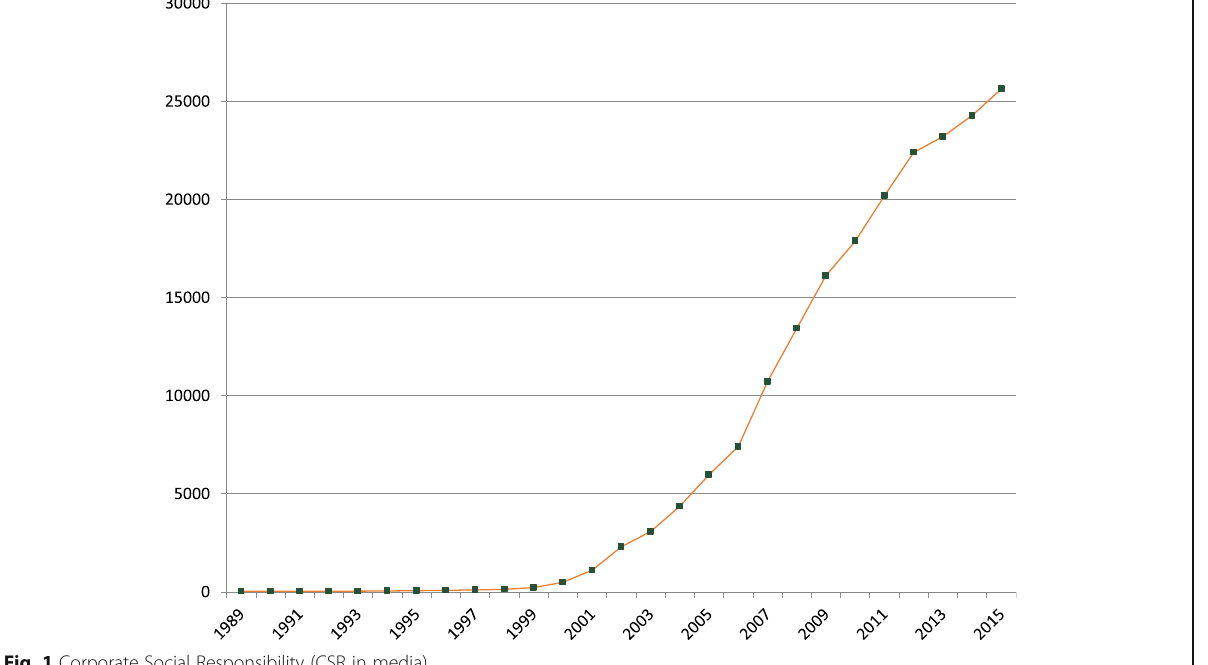
Fig. 1 Corporate Social Responsibility (CSR in